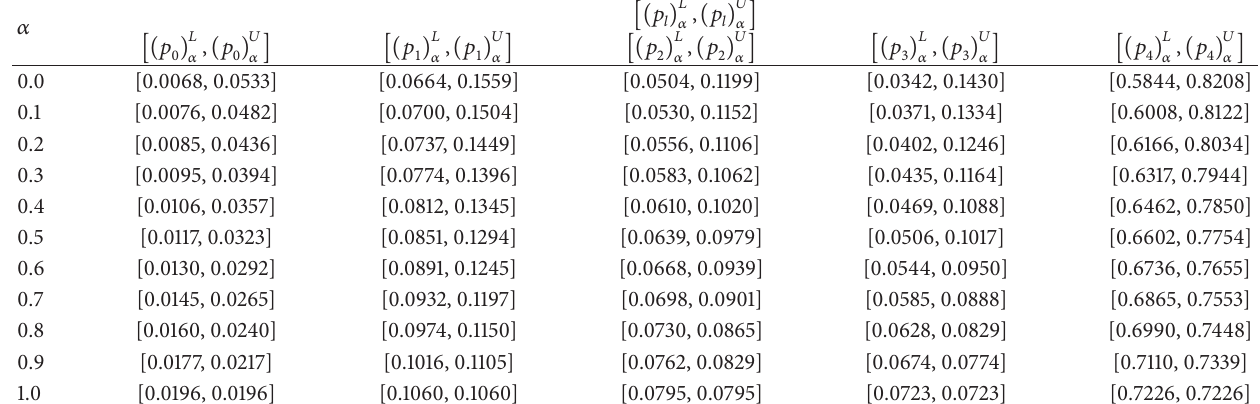
Table 3: The 𝛼 -cuts of the fuzzy state probabilities at 11 𝛼